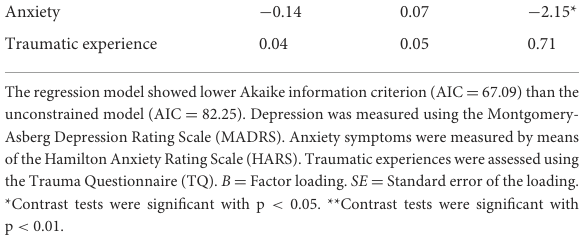
TABLE 2 Clinical predictors to explain glucocorticoid receptors in the patient group, controlled for the antipsychotic prescription. Variable B SE t